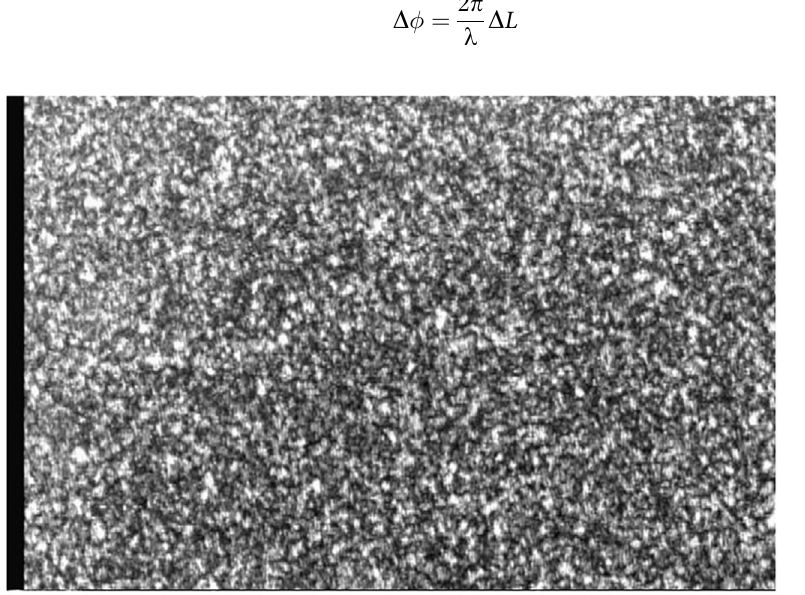
Fig 2. A speckle pattern generated on the illumination point on a root of a Masson pine seedling.